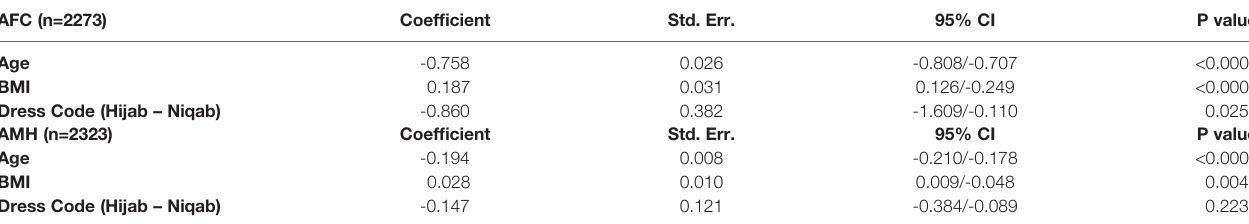
TABLE 6 | Multiple regression analysis for AFC and AMH as dependent variables, including age, BMI and dress code as predictor variables. AFC (n=2273) Coef fi cient Std.